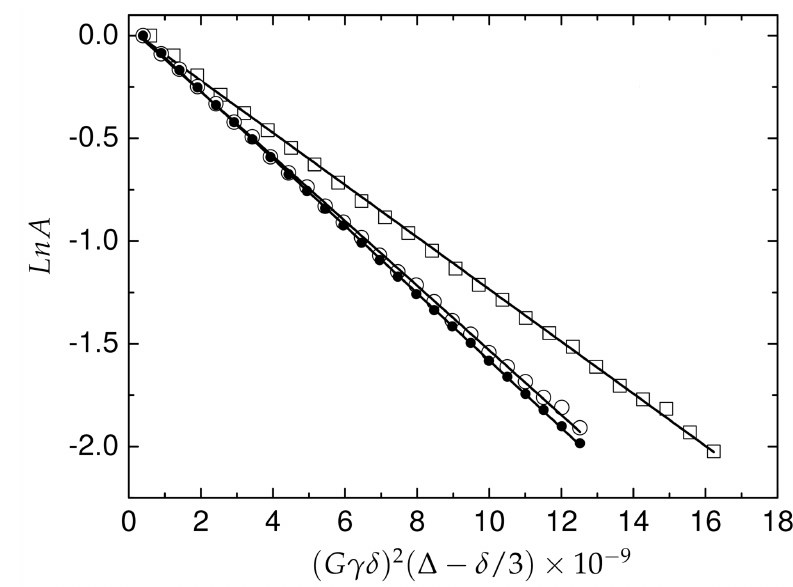
Figure 7. Integral attenuation vs. gradient amplitude in PGSE NMR experiment for A β 4 − 16 and Pd(A β 4 − 16 ) complex in solution. The apo A β 4 − 16 peptide (filled circles), equimolar Pd(A β 4 − 16 ) complex 1:1 (open circles) and 1:1.4 (open squares). The experiments were performed on a Varian Inova 500 NMR